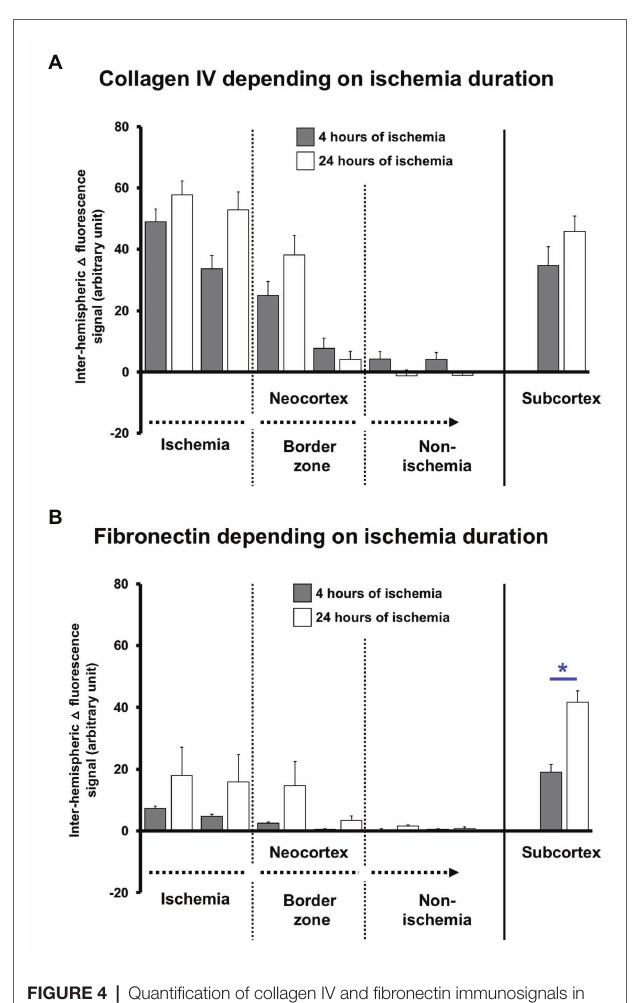
FIGURE 4 | Quantification of collagen IV and fibronectin immunosignals in mice depending on the duration (4 vs. 24 h) of experimental focal cerebral ischemia. Inter-hemispheric differences covering the immunosignals of collagen IV (A) and fibronectin (B) depending on the duration of ischemia confirms the gradual decrease of the signals along the ischemia-affected neocortex as evaluated in the overall sample. Statistically significant differences are lacking between the 4 and 24 h of ischemia in the neocortex, although a trend is visible for a pronounced signal at the later time point. In the subcortex, the immunosignal of fibronectin increased at 24 h as compared with the earlier time point. Bars represent means and added lines represent the standard error of means. Level of statistical significance: * p <